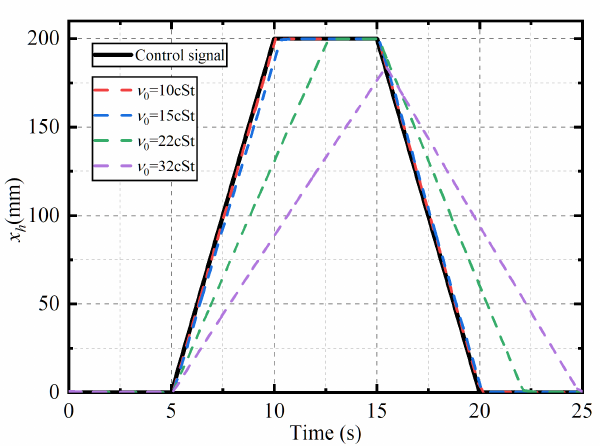
Figure 14. Displacement output, x h , at different initial kinematic viscosity of hydraulic oil, ν 0 , when depth is 11